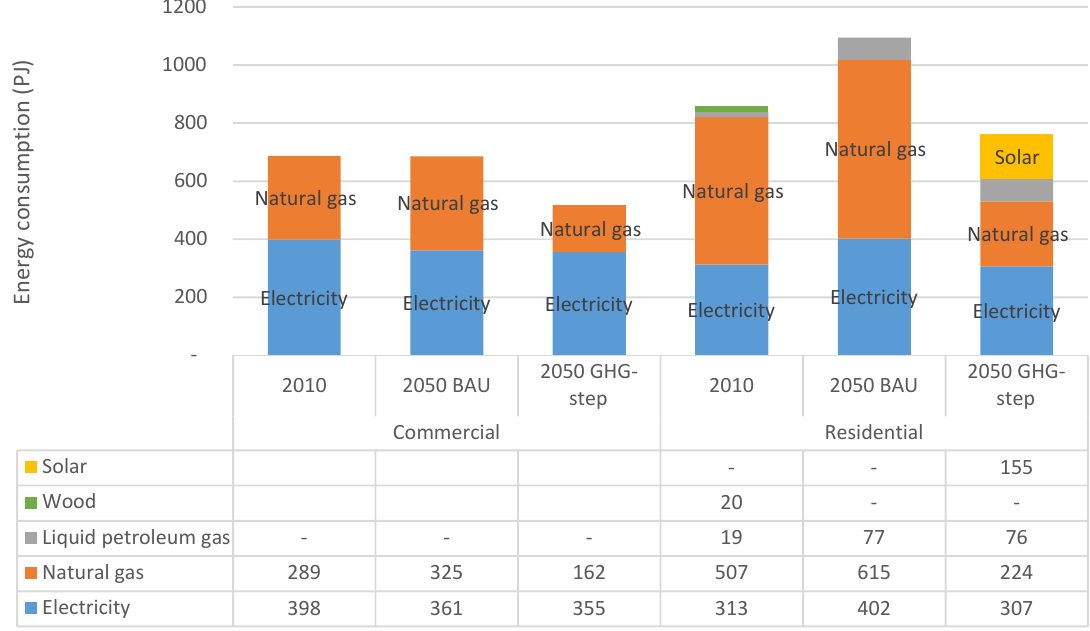
Figure 9. CA-TIMES energy consumption by energy resource and scenario for commercial and residential use.